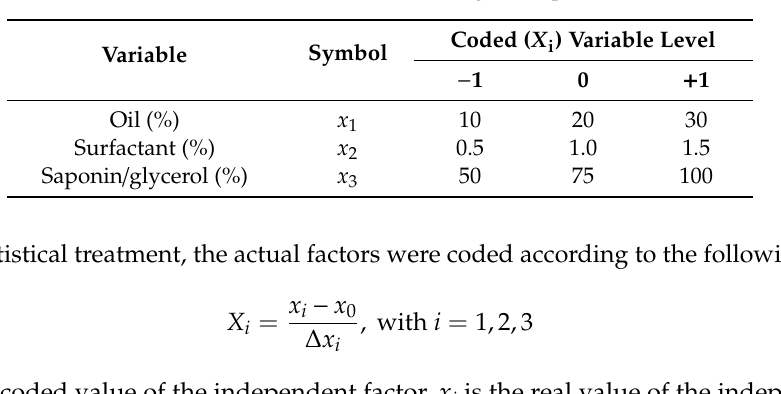
Table 4. Parameter definition for design of